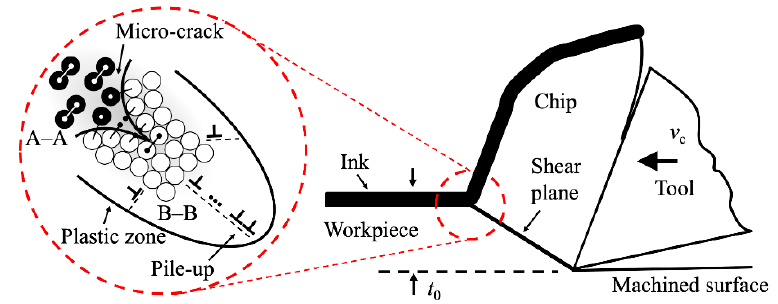
Figure 10. Schematic of the microcrack propagation from the free surface of the adsorbed chip [23].